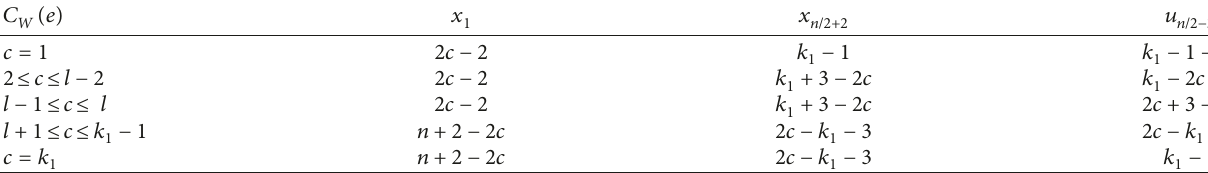
u c is odd. c c , when